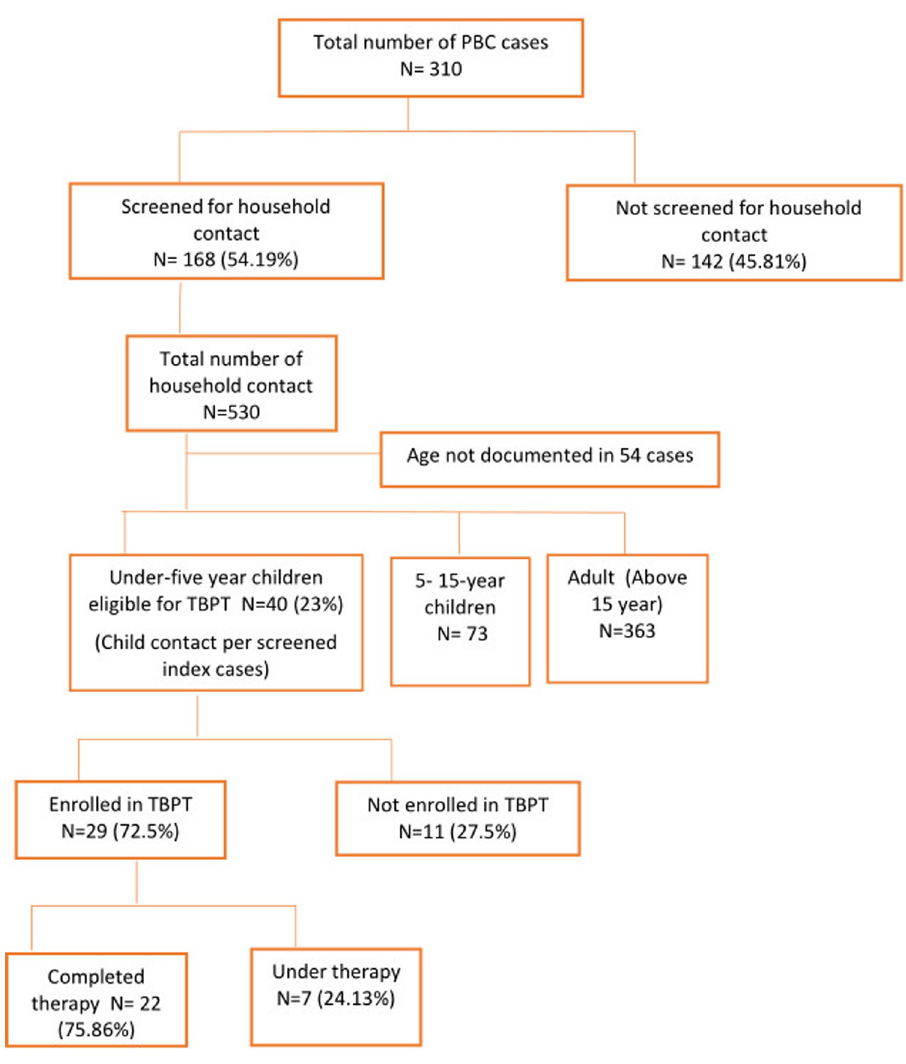
Fig 1. Contact tracing of PBC cases and TBPT enrolment of under five children.